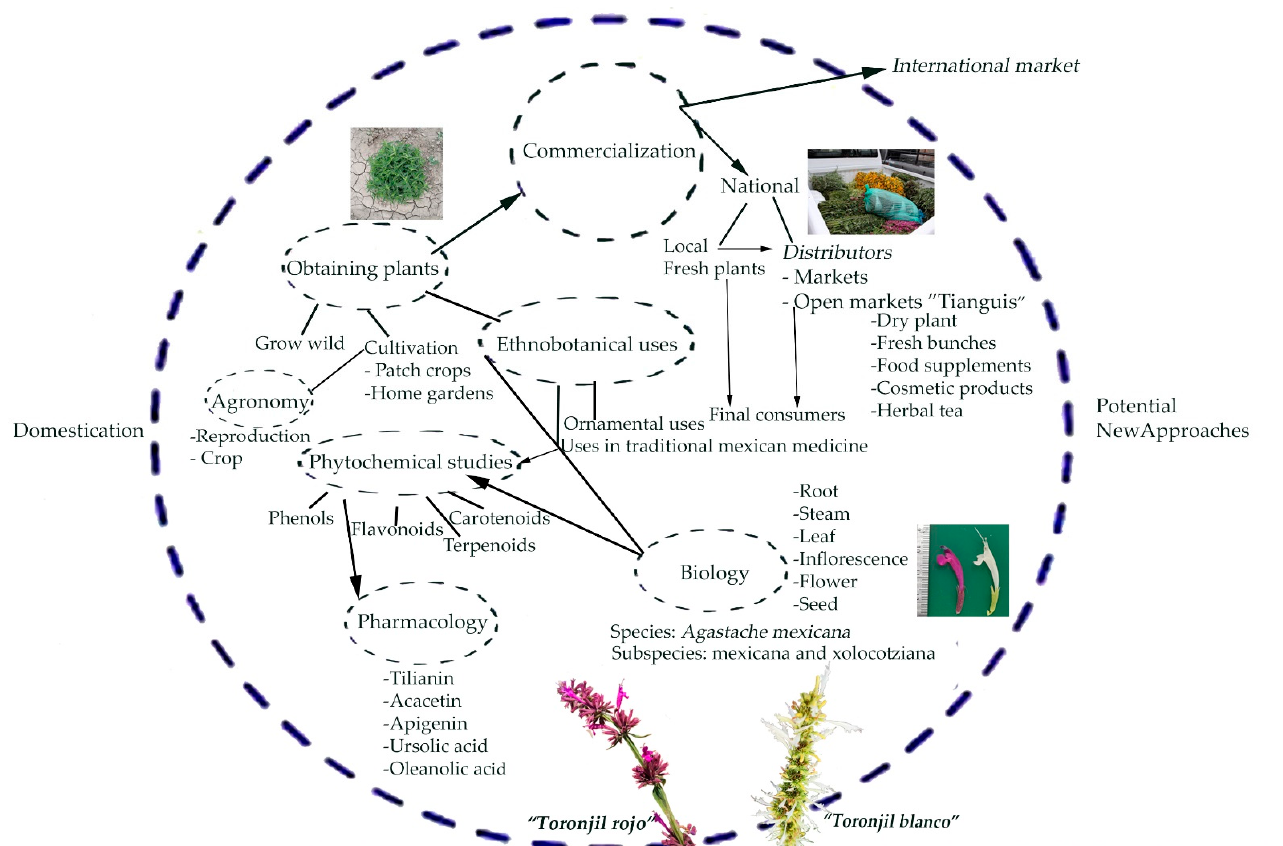
Figure 2. Systems biology approaches of the study of Agastache